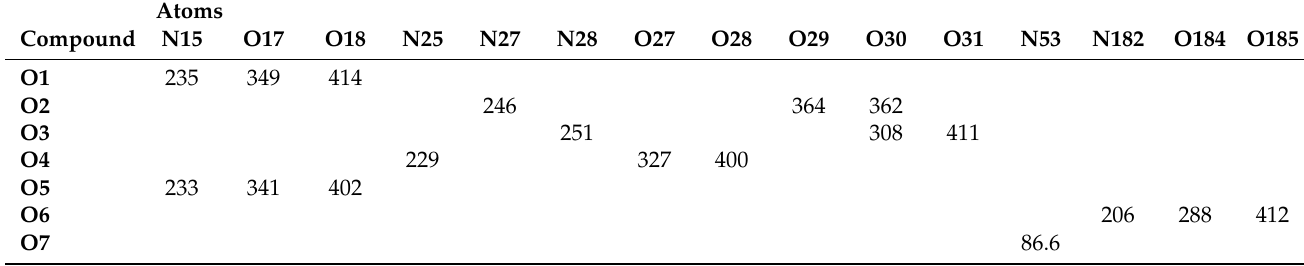
Table 2. Electronegativities on the anchoring segments obtained through molecular electrostatic potentials ( − 1 × 10 3